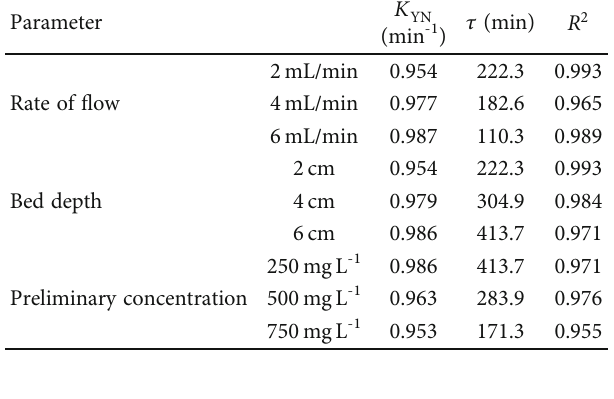
Table 4: Yoon-Nelson model parameters for the removal of Pb 2+ ions by ZSM-5/AC.